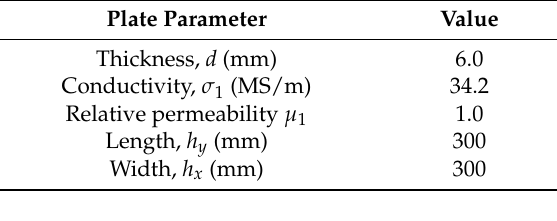
Table 2. Parameters of the conductive plate.